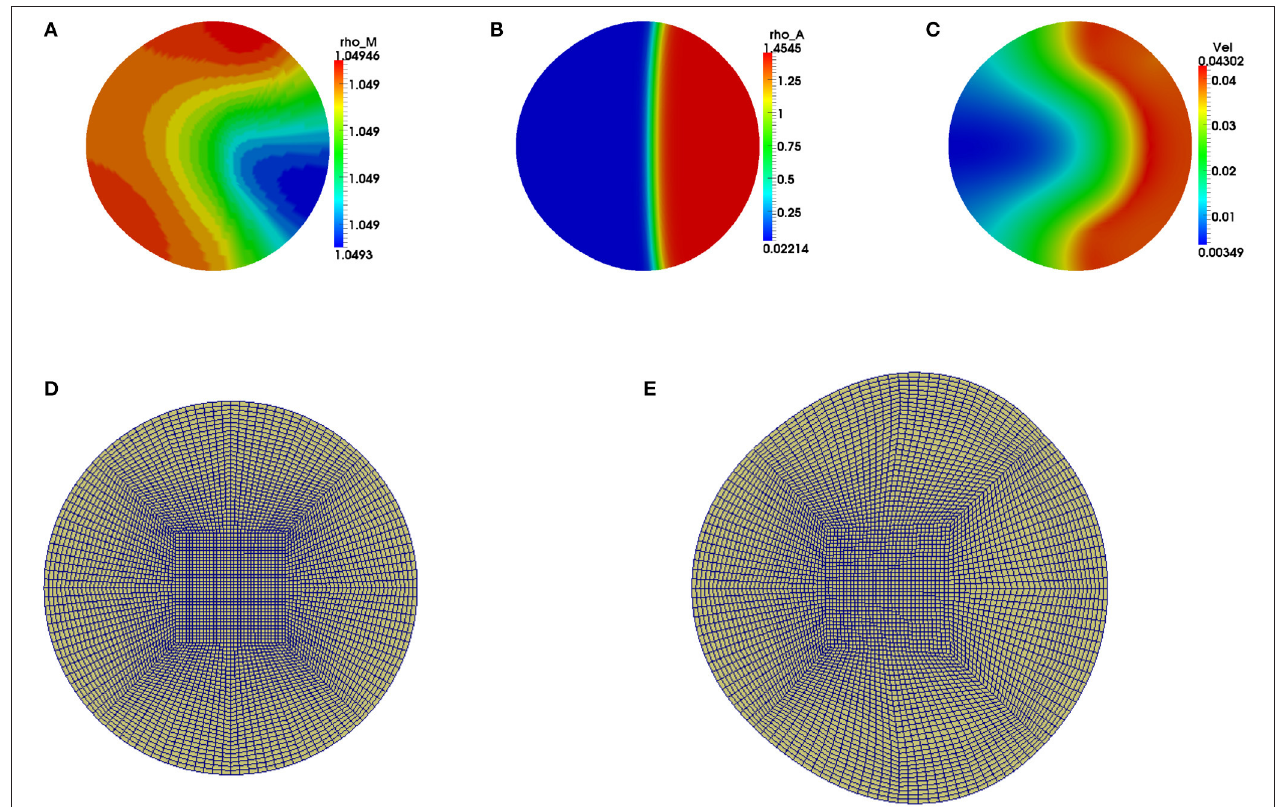
FIGURE 3 | Graphical display of numerical solution illustrating a migrating cell at time t = 4 when considering a non-zero initial condition of ρ a = 1 only in one half of the cell. Blue signifies lowest values while red signifies highest values. (A) Solution for ρ m variable, (B) solution for ρ a variable and (C) cell speed at final time. Polymerization of actin leads to cell deformation where the cell expands more in the regions with higher actin filament concentrations. (D,E) are the finite element meshes of the simulations at initial and final times, respectively, which have been enlarged for